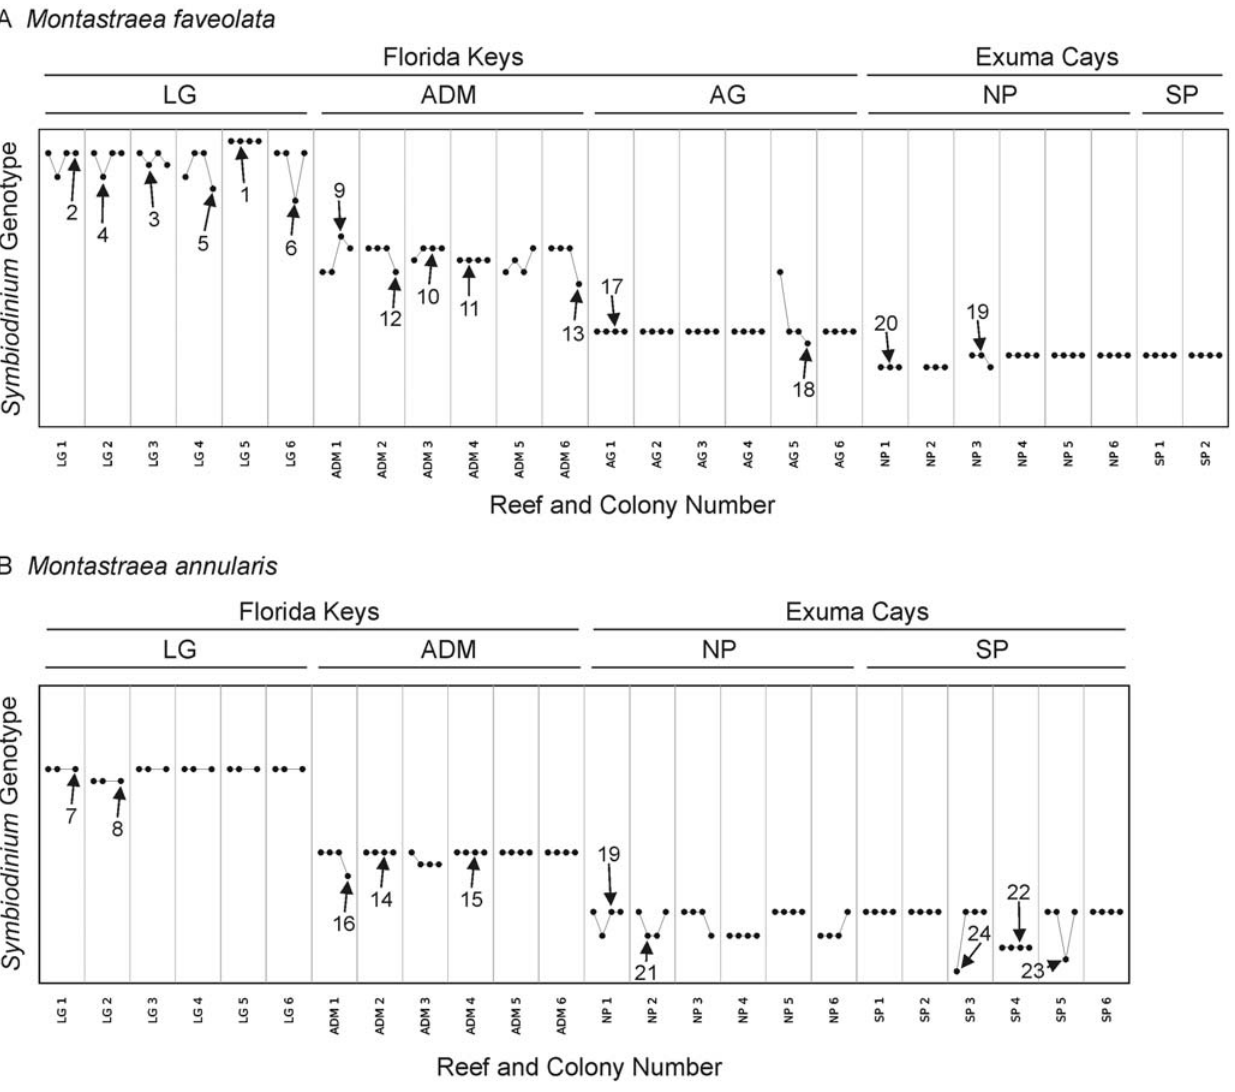
Figure 2. Categorical plots of Symbiodinium Clade B multilocus genotypes within Montastraea spp. colonies over time. Symbiodinium Clade B multilocus genotypes detected within specific colonies of the corals Montastraea faveolata (A) and M. annularis (B) from the Upper Florida Keys (U.S.) and Exuma Cays (Bahamas). On the y-axes, each unique Symbiodinium genotype is assigned a specific vertical position. Arrows and numbers indicate the specific Symbiodinium multilocus microsatellite genotype; numbers correspond to genotype numbers presented in Table 4. The x-axes depict each of the tagged colonies ( n =50) tracked during this study. Four data points are presented for each colony, corresponding to genotypes detected during each of the four sampling dates (left to right; Florida Keys: March 2003, March 2004, Sept. 2005 and Dec. 2005; Exuma Cays: Jan. 2003, Jan. 2004, Sept. 2005, Nov. 2005). Colonies with only three data points indicate missing data for a particular sampling period. Stability of a Symbiodinium population within a coral colony is depicted as a straight, horizontal line whereas changes in the symbiont genotype detected are indicated as a vertical shift between sampling periods. The reef and region for each colony is noted above the graph (reef abbreviations correspond to Fig. 1).